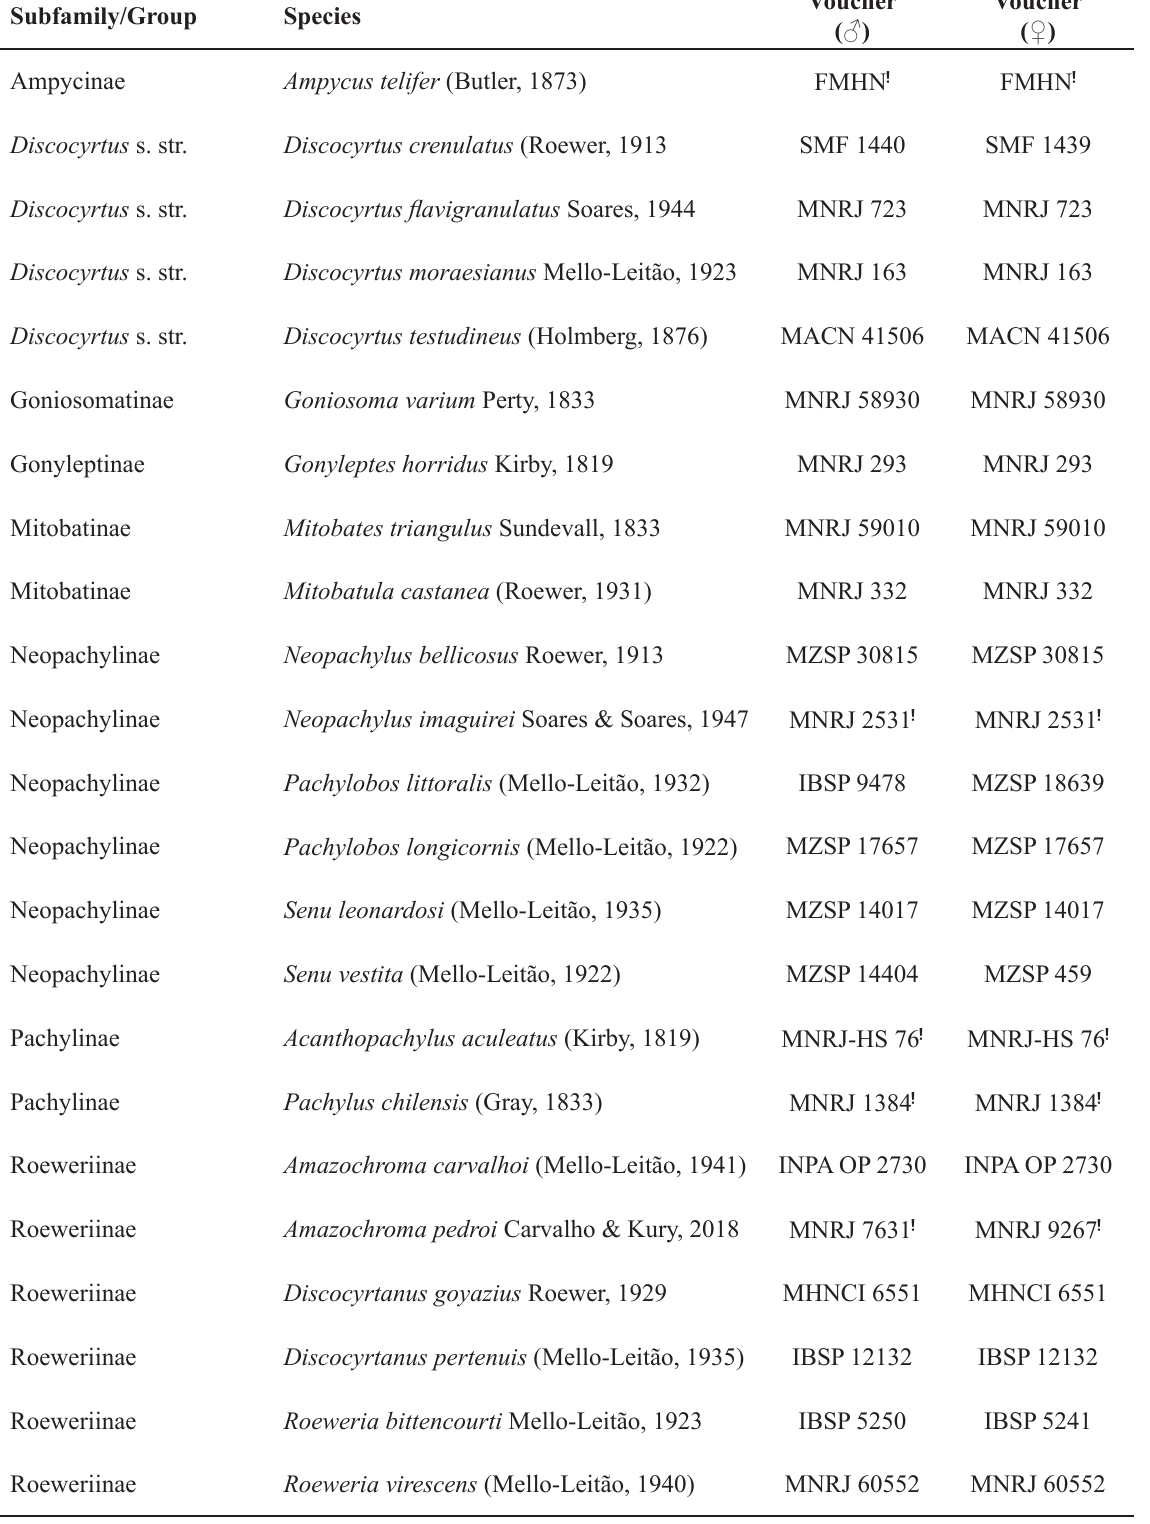
Table 1. List of the outgroup species (with specimen vouchers) selected for the present cladistic analysis.